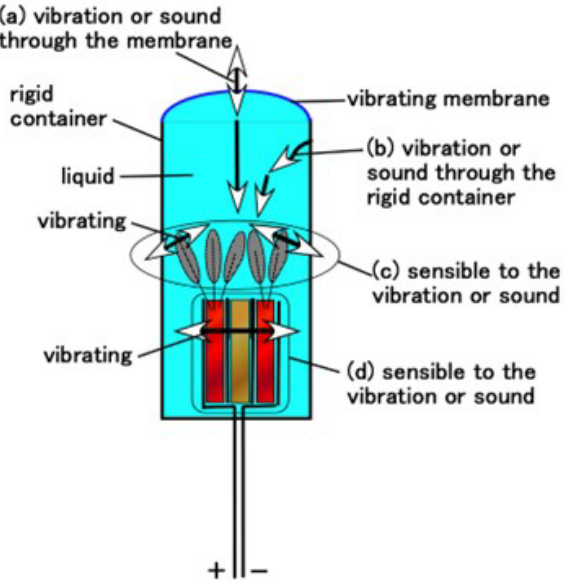
Figure 16. Schematic of physical model of acoustic performance by vibration of sound wave on auditory sensor mimicking the organ of Corti.